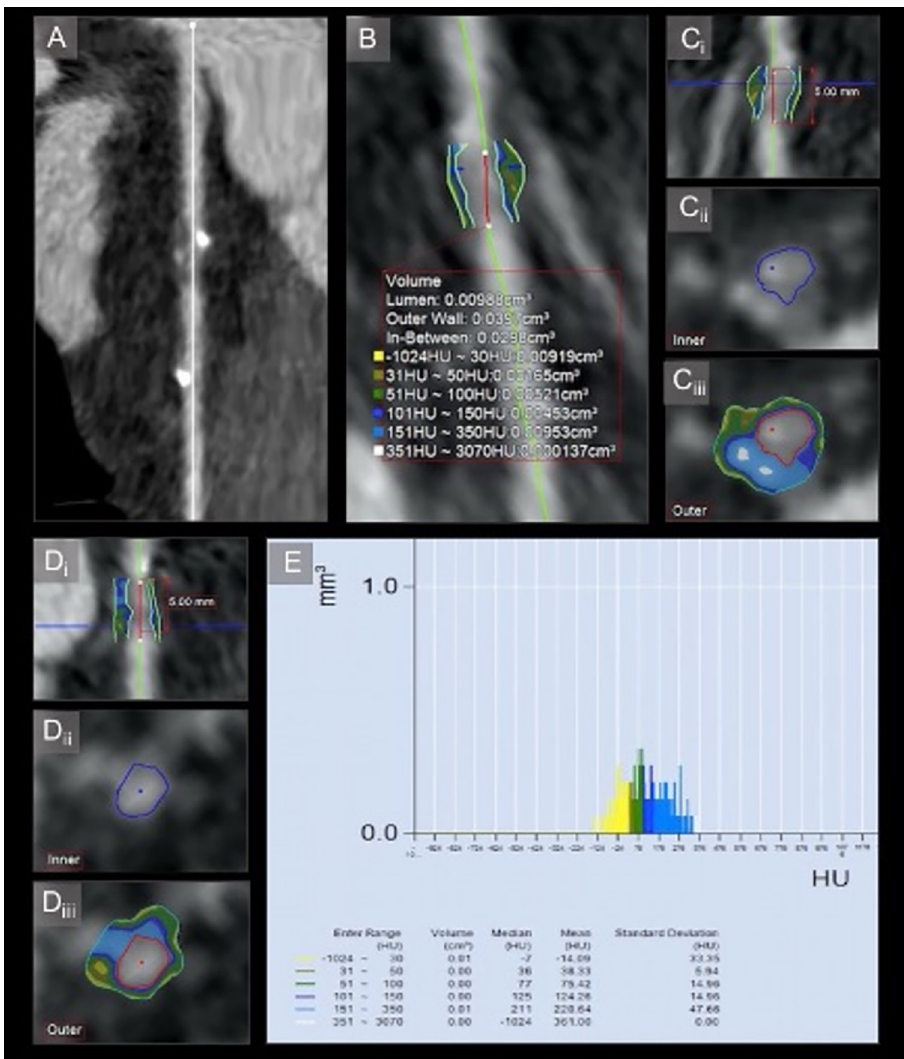
Fig 3. Volumetric plaque analysis. (A) Straightened MPR. There is stenosis at the proximal edge of the BRS in middle left anterior descending coronary artery. (B) Volumetric analysis of plaque HU-stratification. (Ci) Position within the plaque of the axial slice presented in views Cii and Ciii. (Cii) Axial view of lumen in Ci slice. (Ciii) Axial view of the mixed plaque with color-coded LAP and two spotty calcifications. (Di) Position within the plaque of axial slice presented in views Dii and Diii. (Dii) Axial view of lumen in Di slice. (Diii) Axial view of color-coded LAP plaque. (E) Histogram of the plaque composition stratification. LAP (9.19 mm 3 ) represents one third of the total plaque